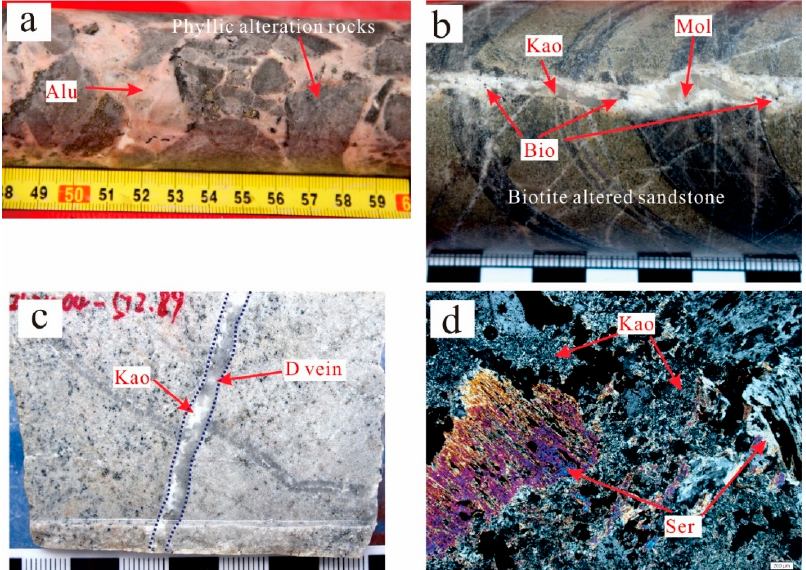
Figure 3. The epithermal alteration overprinted on the porphyry alteration. ( a ) Alunite breccia